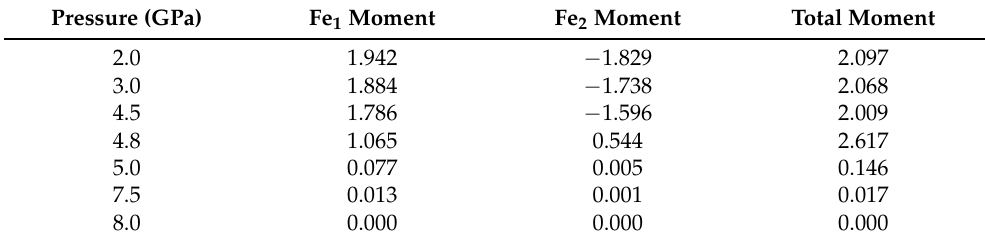
Table 6. Magnetic moments (in µ B ) of iron atoms on two sites, Fe 1 and Fe 2 , and total magnetic moments per Fe 3 Se 4 formula unit of Fe 3 Se 4 under external pressure. The Wigner–Seitz radius for Fe ions is 1.302